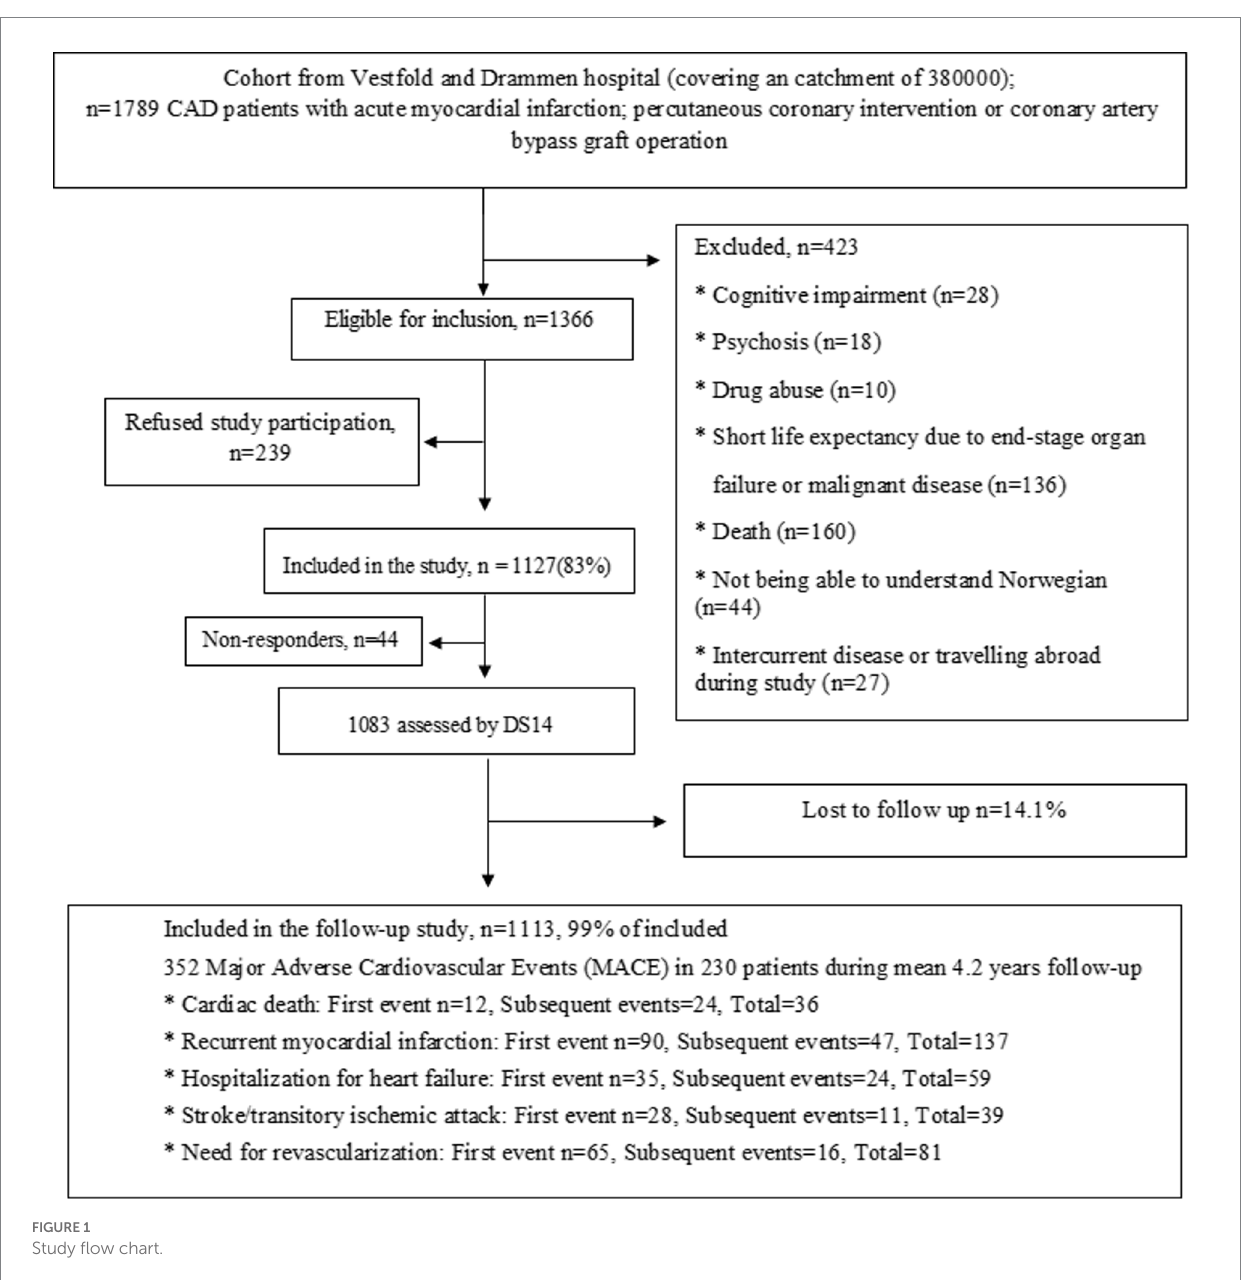
FIGURE 1 Study flow